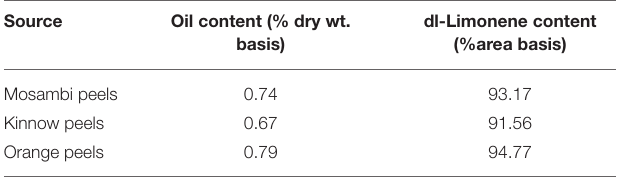
TABLE 1 | Essential oil yield and limonene content in essential oil of three Citrus sp.